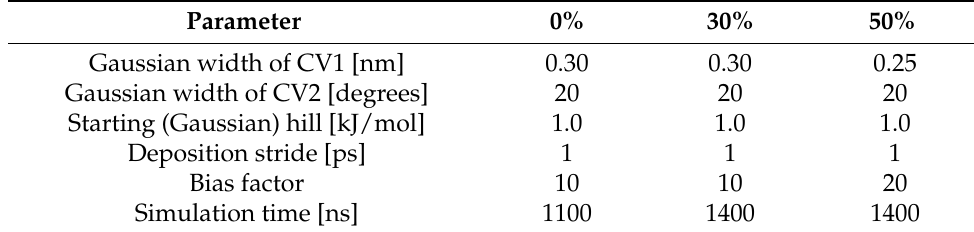
Table 6. WTM simulation